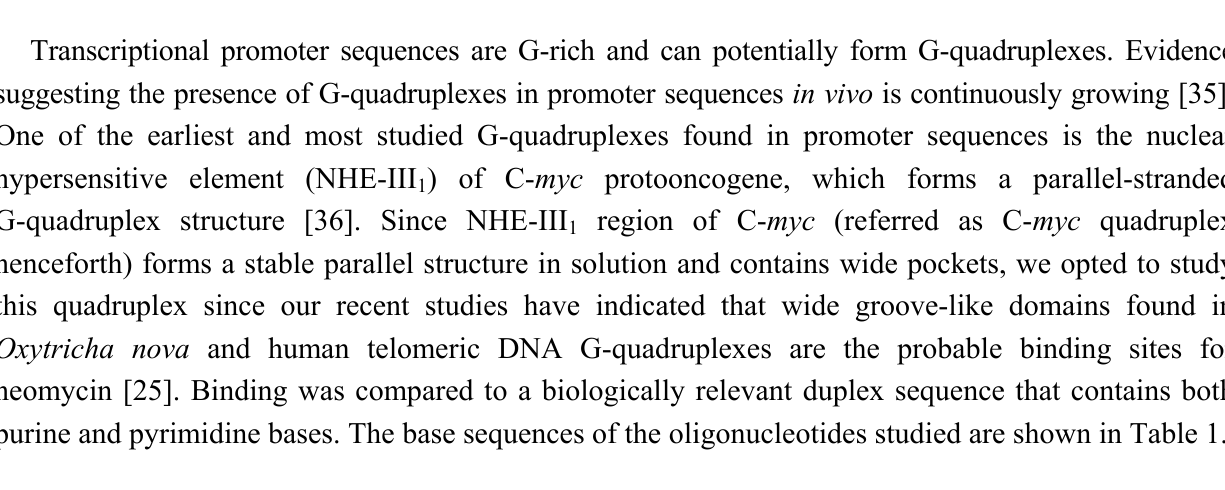
Table 1. DNA base sequences of the oligonucleotides used in the